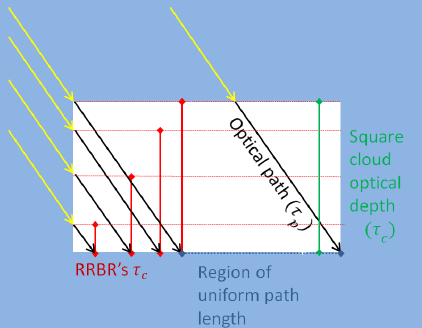
Figure 11. Illustration demonstrating differences between RRBR measured cloud optical depth, cloud optical depth, and cloud optical path. Figure 10. (a) USI image for 25 March 2013, 22:10:00UTC. (b) τ c retrieval from the RRBR method. Pixels inside the black ring are the pixels used for averaging and comparison with the (θ 0 ,ϑ s ,ϑ z ) . For MWR (Sect. 6.4). (c) RBR meas (ϑ s ,ϑ z ) . (d) I meas 620 this scene, the MWR measured a τ c of 0.56 and the USI measured a τ c of 0.20, the highest τ c readings within 10min of this image are 19.4 and 15.3 for the MWR and USI respectively.